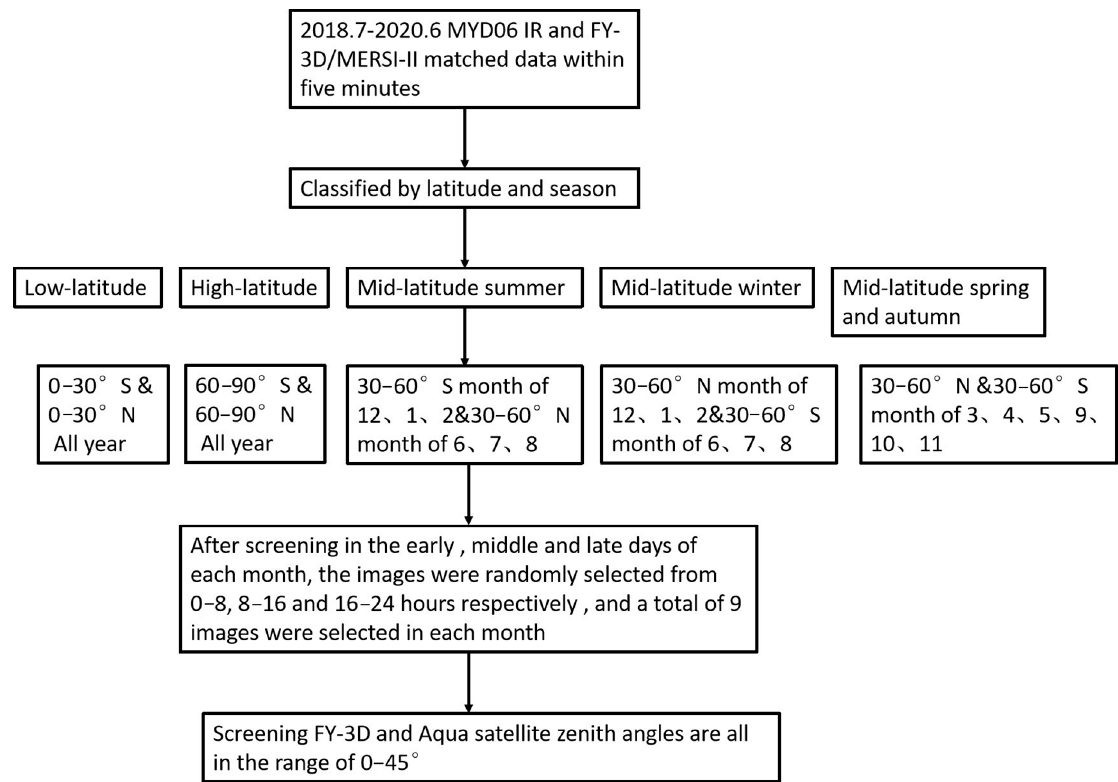
Figure 1. Process for selecting training and verification data according to season, latitude, time period, and satellite